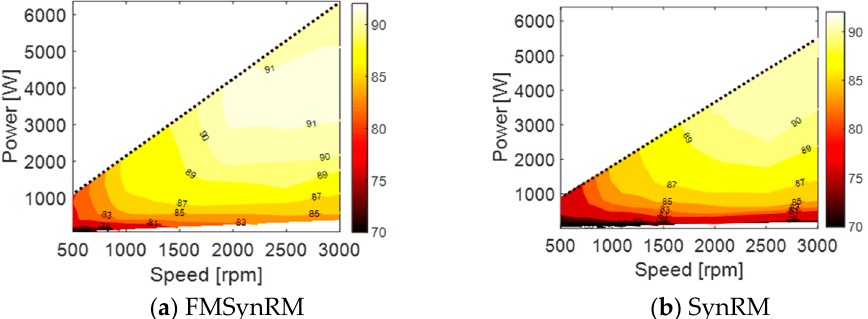
Figure 16. Measured whole drive (motor + inverter) efficiency map.